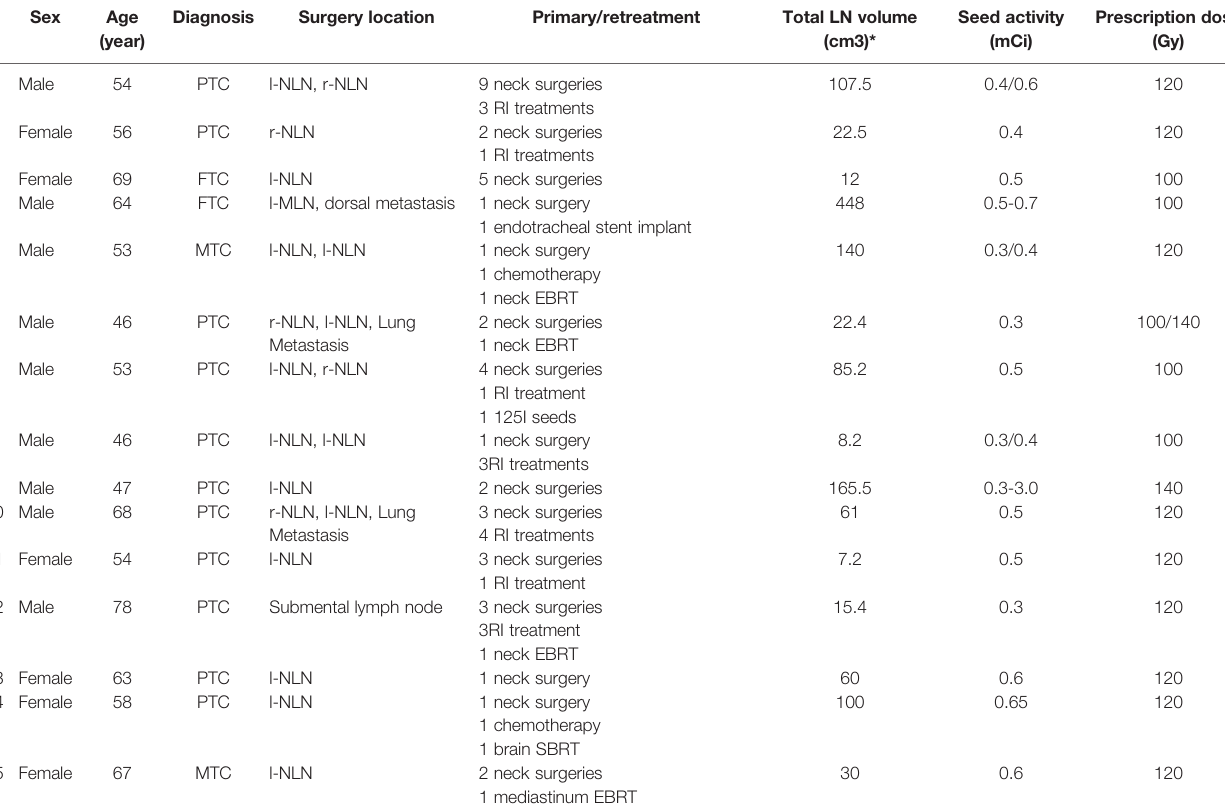
TABLE 1 | History of previous treatment in fi fteen patients who received brachytherapy for neck LN